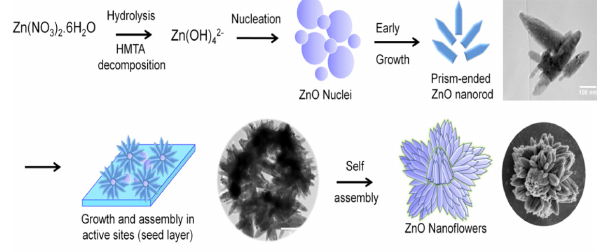
Figure 1: Schematic growth and formation mechanism of ZnO nanoflowers. Decomposition of HMTA yields HCHO and NH while Zn(NO ) is hydrolyzed. Zn 2+ cation reacts with NH 3 2 form Zn(NH ) 42+ , which later reacts with OH - to form Zn(OH) 42- . 3 Subsequently, Zn(OH) 42- forms ZnO nucleus, which grows on active sites for self-assembling into a dense ZnO nanoflower structure.